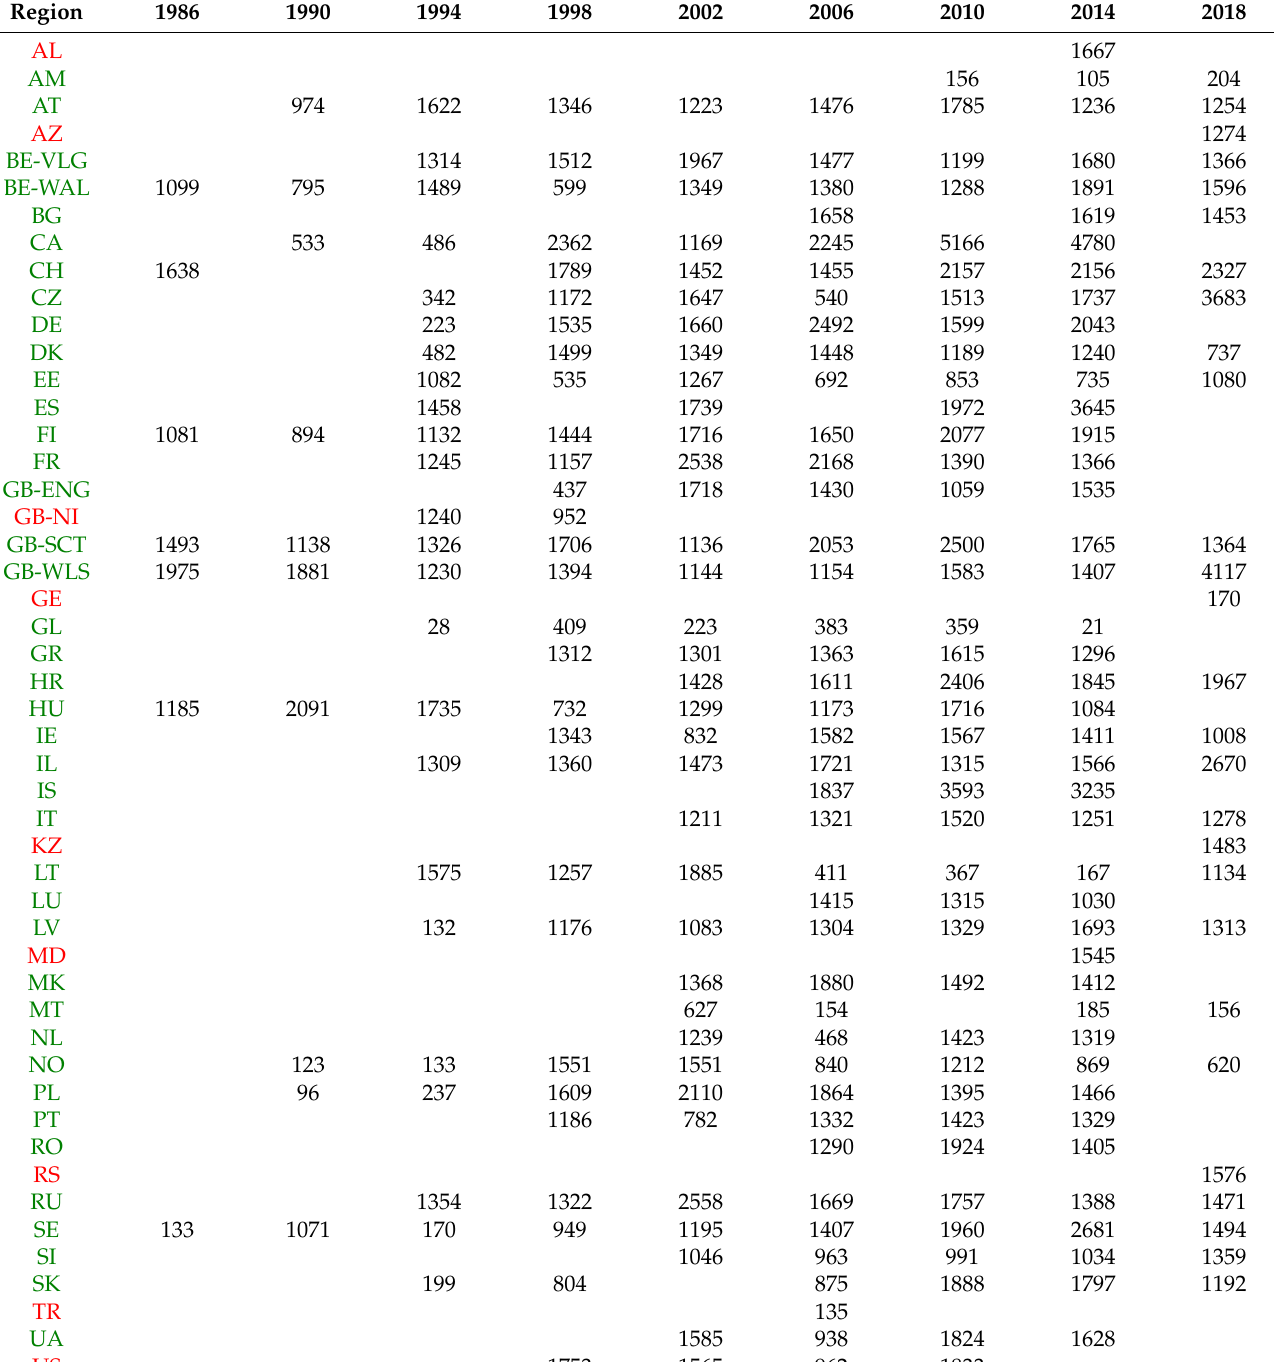
Table A1. Participation in HBSC waves from 1986 to 2018, by country. In the table, numbers represent how many 15-year-olds answered questions about alcohol consumption. Countries participating in at least 3 surveys (one of which in 2014 or 2018) were included in the analysis highlighted in